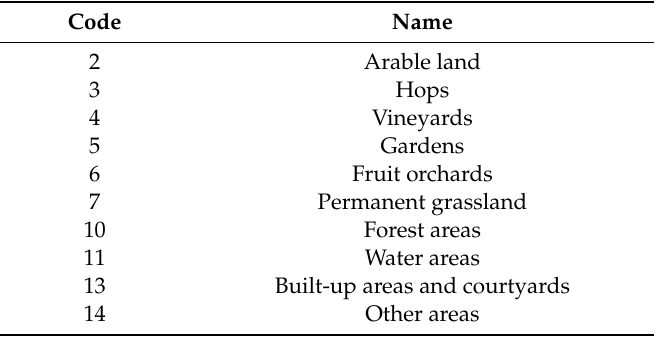
Table 2. Types of KN